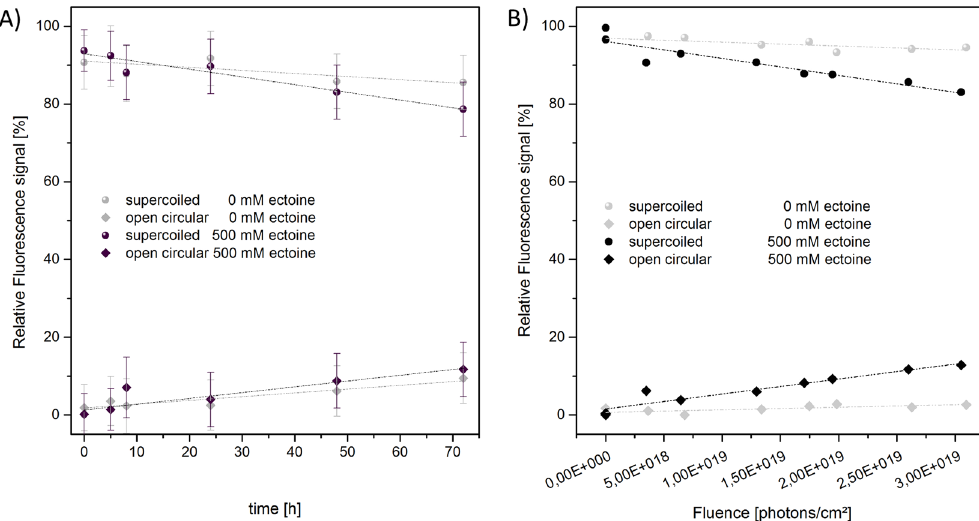
Figure 6. Stability of pUC19 in 10 mM Tris with and without ectoine. The change of plasmid configuration is shown in dependence of time and fluence: ( A ) pUC19 incubated for 0 h to 72 h without irradiation. In buffered solution, stability of DNA is unaltered in solution with ectoine compared to ectoine-free buffer. ( B ) pUC19 samples incubated for 5 h and UV-A irradiation. The lines are guides to the